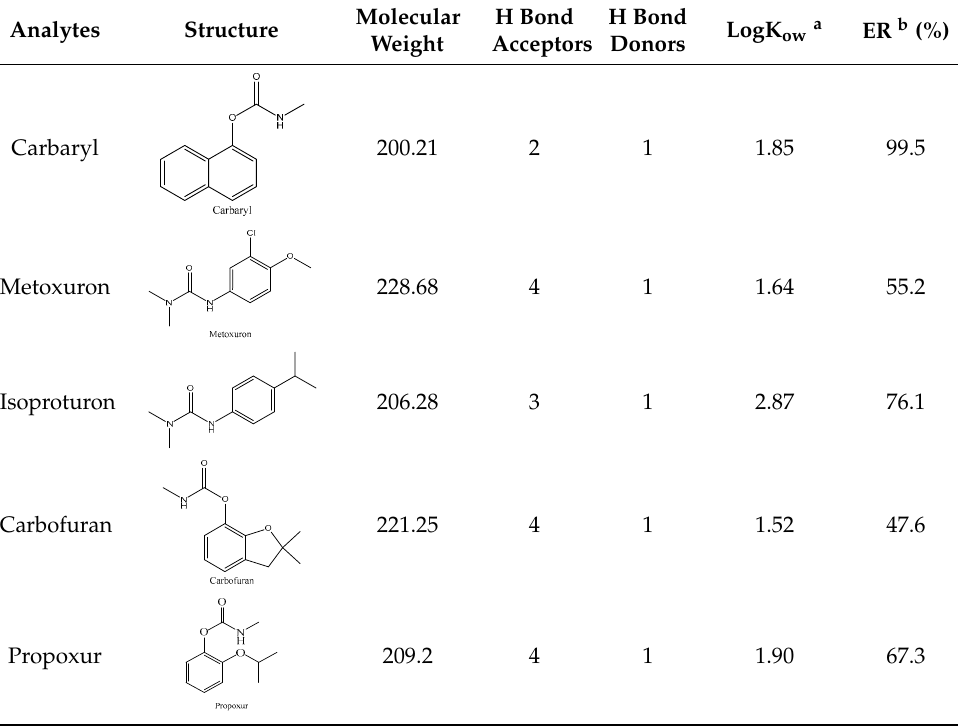
Table 1. Adsorption of other pesticide with magnetic COF (TpPa-NH 2 )@Fe 3 O 4 .